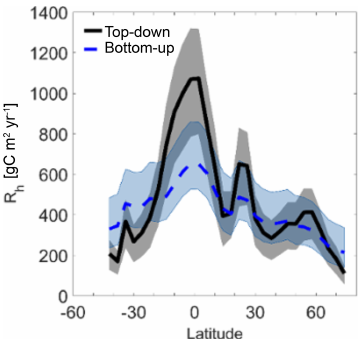
Figure 7. Distribution of all SRDB experiments (dashed red lines) and global land points where top-down retrievals were possible in terms of (a) latitude and (b) bottom-up modeled R h . Modeled R h rather than observed R h were used for the SRDB data in the com- parison to isolate the differences due to the representativeness of the SRDB experiments relative to the entire global land area and to remove any possible effects of biases in modeled global values and observed SRDB values.